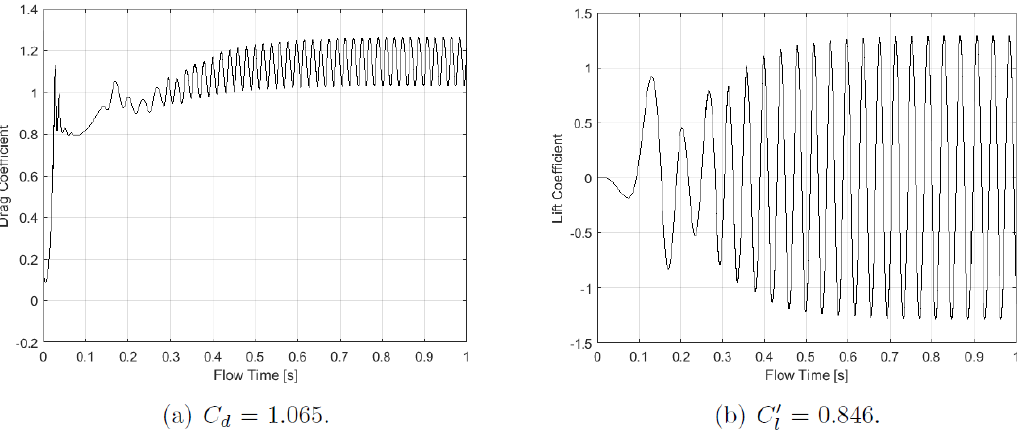
Figure 2. ( a ) Drag coefficient and ( b ) lift coefficient as a function of flow time during the initial transition period before statistically quasi-steady-state conditions are reached. The data shown represent a smooth cylinder at Re = 4.2 × 10 4